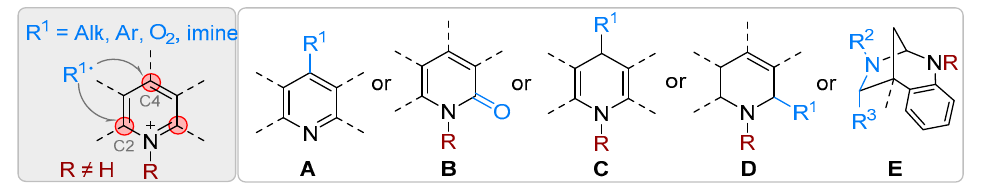
Figure 7. Radical-based transformations of N -Alkyl azaarenium salts.